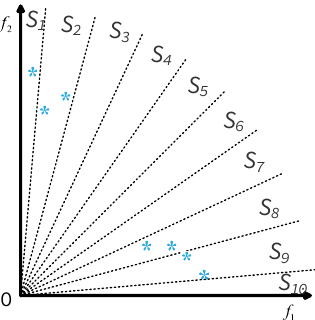
Figure 1. An example of active and inactive subspaces where the blue asterisks denote candidate solutions.